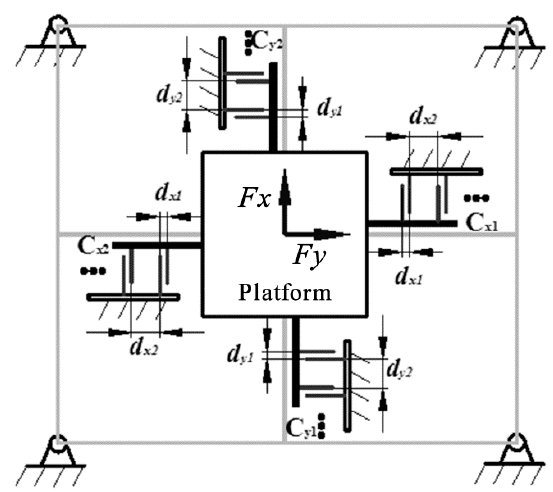
Figure 3. Schematic diagram of a two-axial capacitive force sensor.